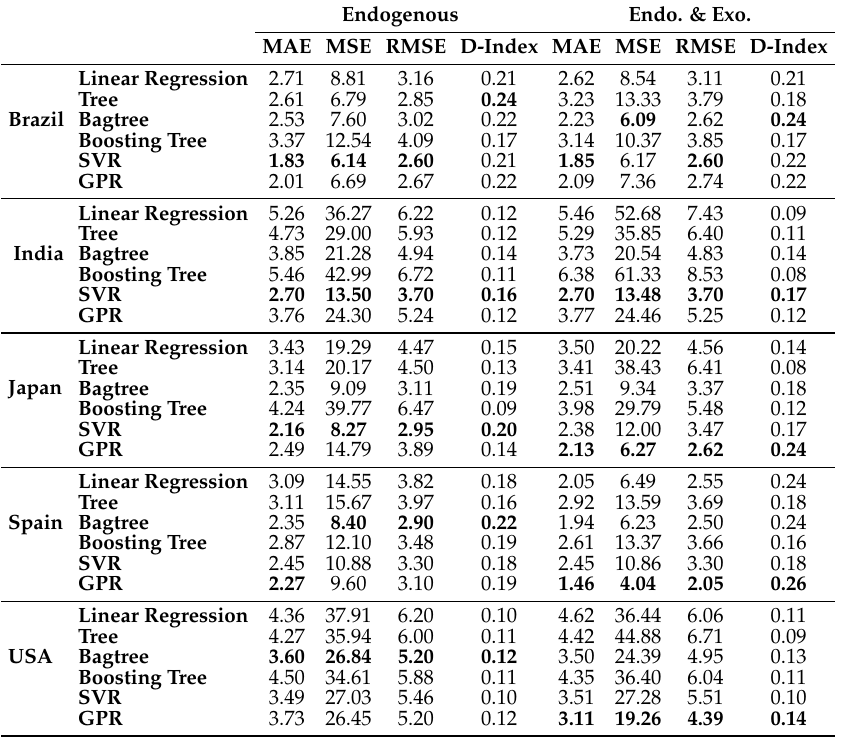
Table 2. Merit figures for estimated EV models in different scenarios. Rows show the results when grouped by regions or countries, and columns show merit figures for the evaluated scenarios, incorporating either only endogenous operational normalized variables, or both endogenous operational normalized and exogenous variables. The best method is painted in bold for each performance measure. Endogenous Endo. &